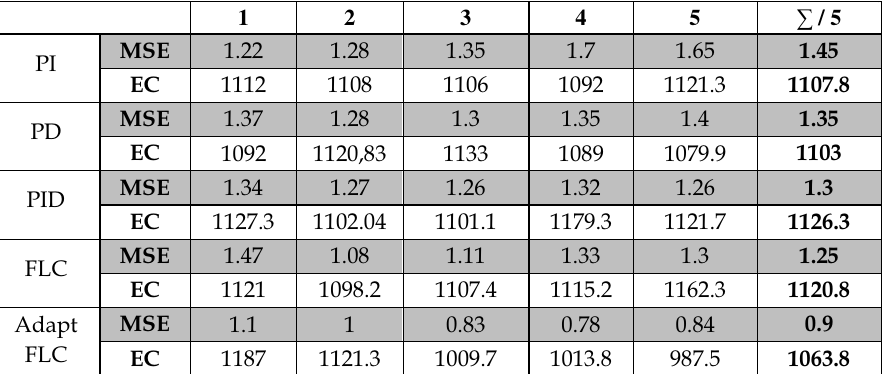
Table 2 ( B ). The MSE obtained during each simulation Set points 2